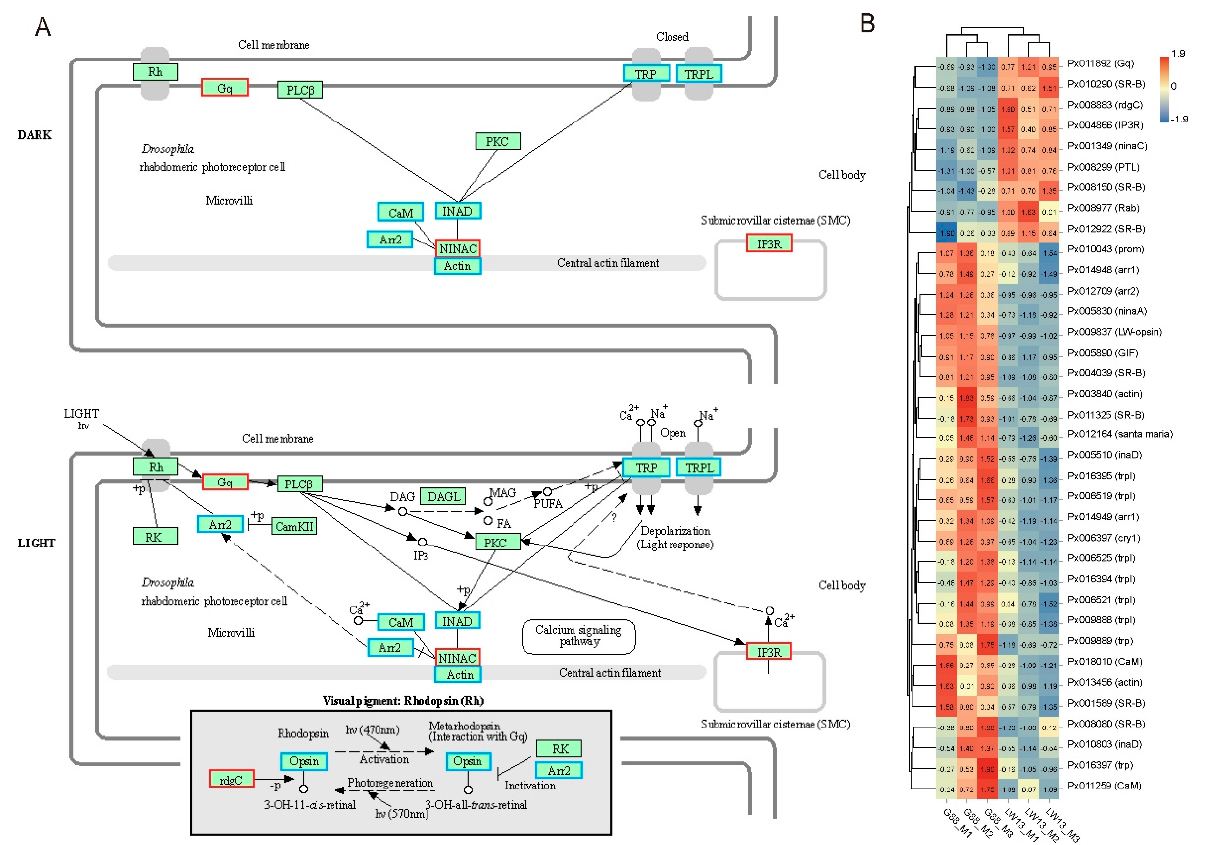
Figure 5. DEGs in LW-13 compared with G88 based on the phototransduction-fly pathway and their heatmap. ( A ) DEGs in LW-13 compared with G88 strains based on the phototransduction-fly pathway. Red and blue frames represent up-regulated and down-regulated DEGs, respectively. ( B ) Heatmap of related DEGs. The value in the box represents the value of the gene’s TPM normalized by the Z -score. 3.6. RT-qPCR Validation of DEGs in the Phototransduction Pathway The gene expression levels of the nine genes of actin , arr1 , CaM , cry1 , inaD , LW-opsin , ninaA , trp and trpl in the phototransduction pathway by the RT-qPCR were consistent with the transcriptome-sequencing results in G88 and LW-13 (Figure 6; r = 0.9136, p = 0.0006). It was worth noting that the LW-opsin mutation caused a remarkably lower mRNA expression of mutant LW-opsin , indicating the reliability of our transcriptomic data. 3.7. The Effects of cry1 Mutation on Phototactic Behavior of P. xylostella The male P. xylostella with a 2-bp deletion in cry1 (Cry1-KO) showed higher phototactic rates to UV and blue lights than the male G88 (Figure